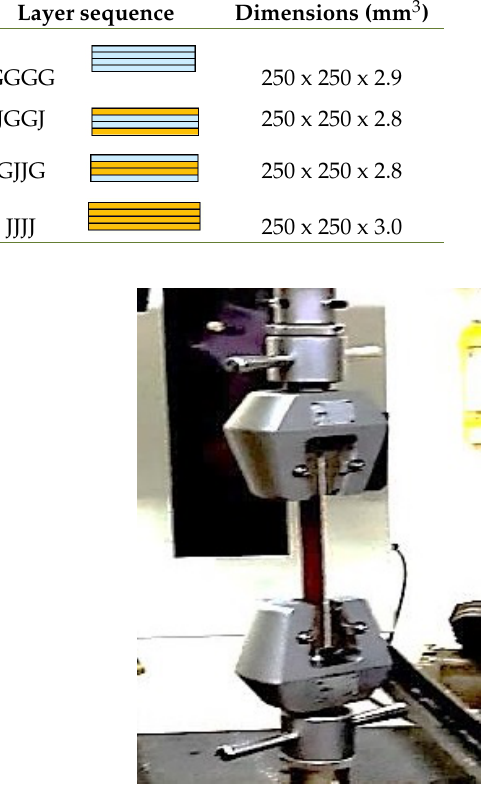
Fig. 3. Tensile test carried out for glass/jute hybrid ® laminate in INSTRON